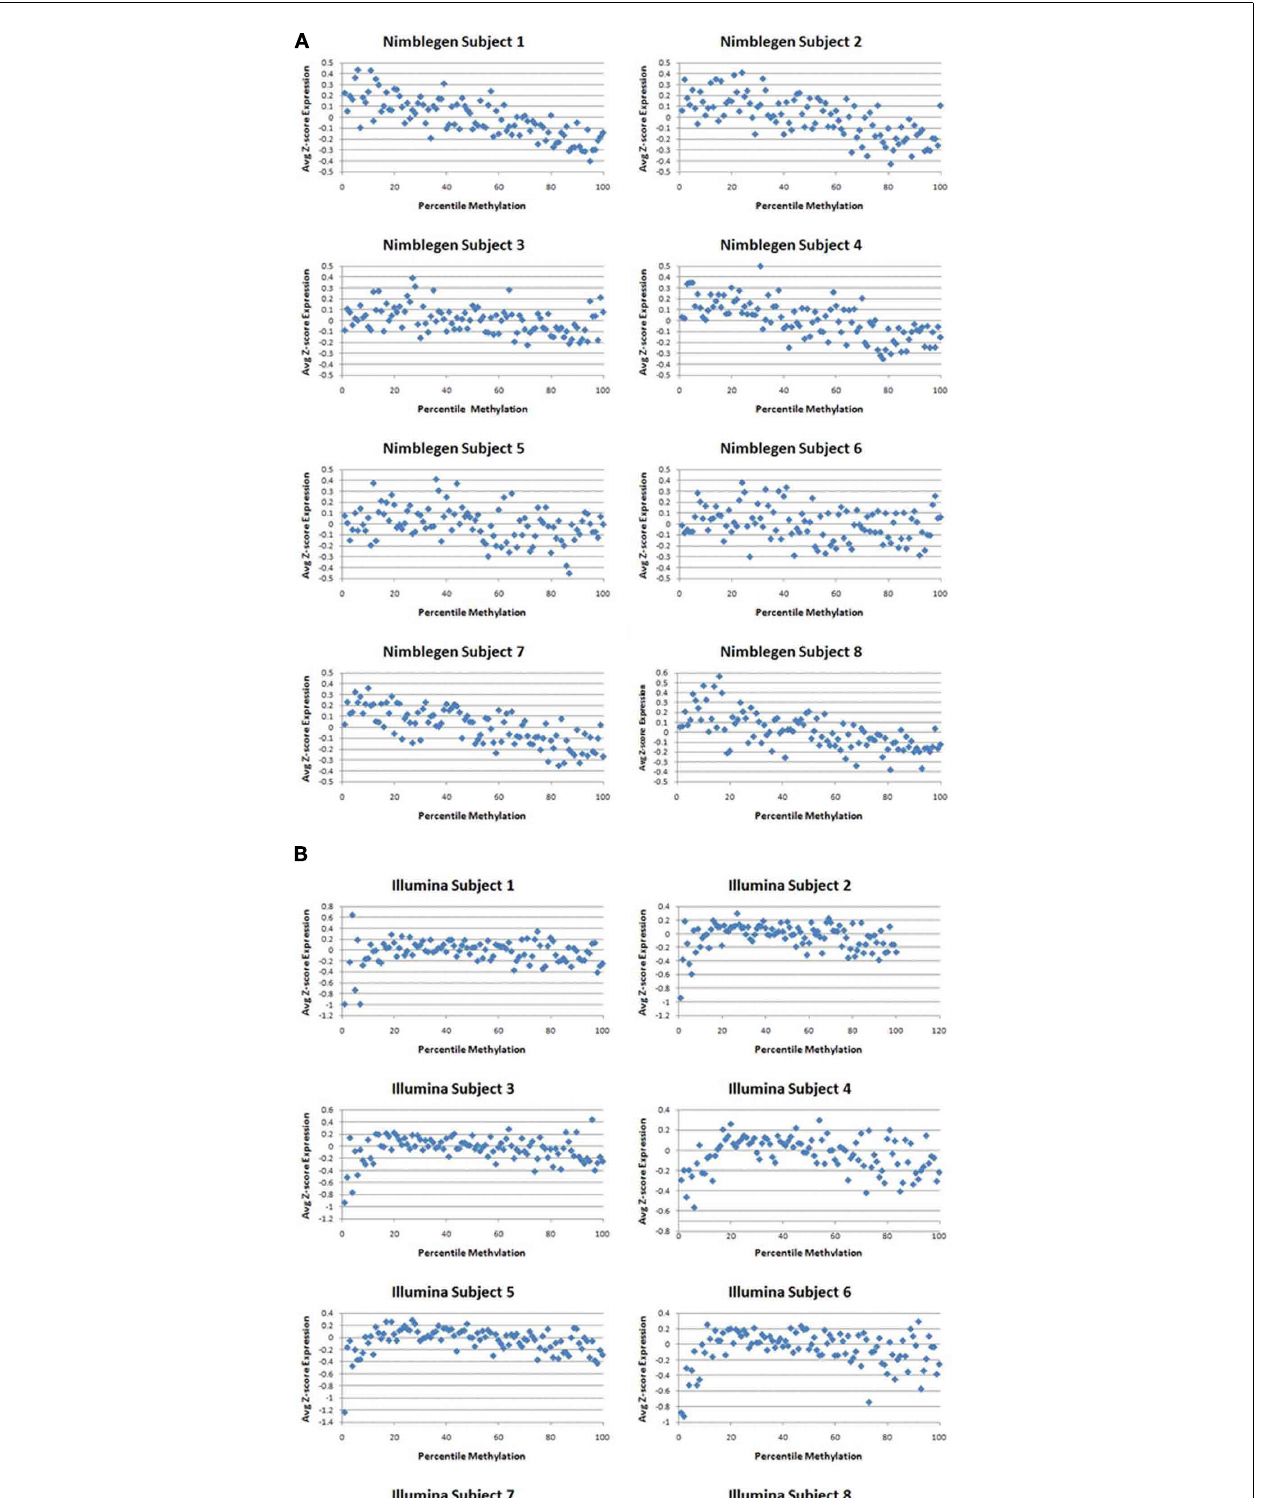
Frontiers in Genetics |